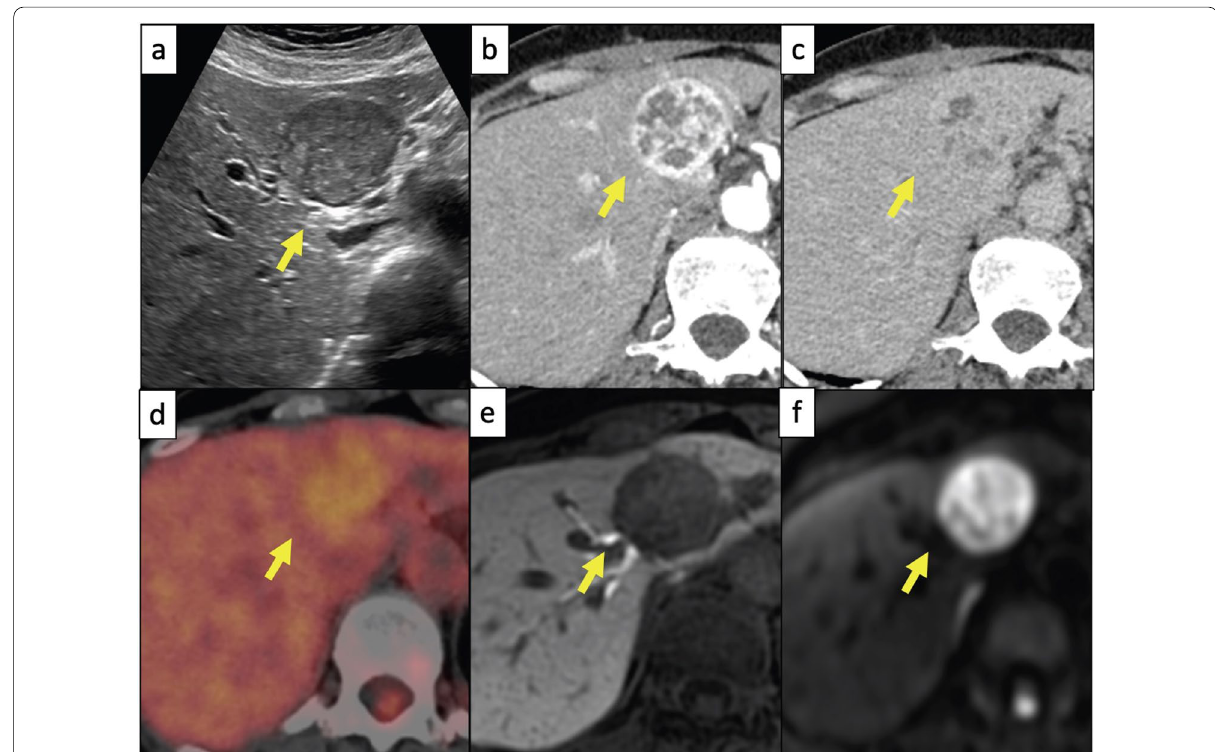
Fig. 1 Preoperative imaging of a tumor. a Abdominal ultrasound showing a 4-cm mass in liver segment IV. b Tumor is heterogeneously enhanced with peripheral enhancement in the arterial phase of dynamic CT. c Early enhancing area is iso-intense to the liver parenchyma in the equivalent phase of dynamic CT. d FDG–PET shows slight hyperaccumulation in the tumor. e Signal of the tumor is markedly lower than that of the liver parenchyma in the hepatobiliary phase of gadolinium–ethoxybenzyl-diethylenetriamine penta acetic acid-enhanced MRI. f High signal intensity on diffusion-weighted image ( b value of 1000 s/mm 2 ) is noted. CT: computed tomography; FDG–PET: fluorodeoxyglucose–positron